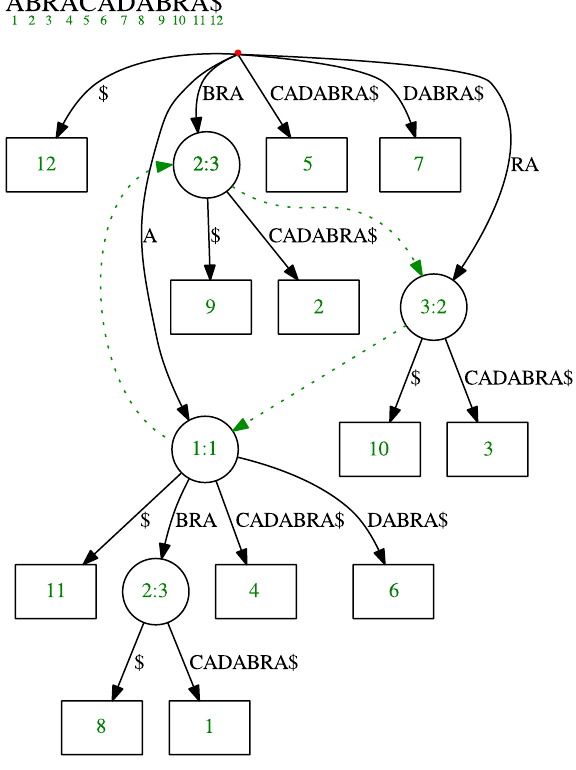
Figure 1. Illustration of the suffix tree for text ABRACADABRA$ including the implicit labels. Suffix links connecting internal nodes are drawn as dotted green lines. Values in each internal node represent the start index and the length of a label on the incoming edge, whereas the value of a leaf represent the suffix position in the